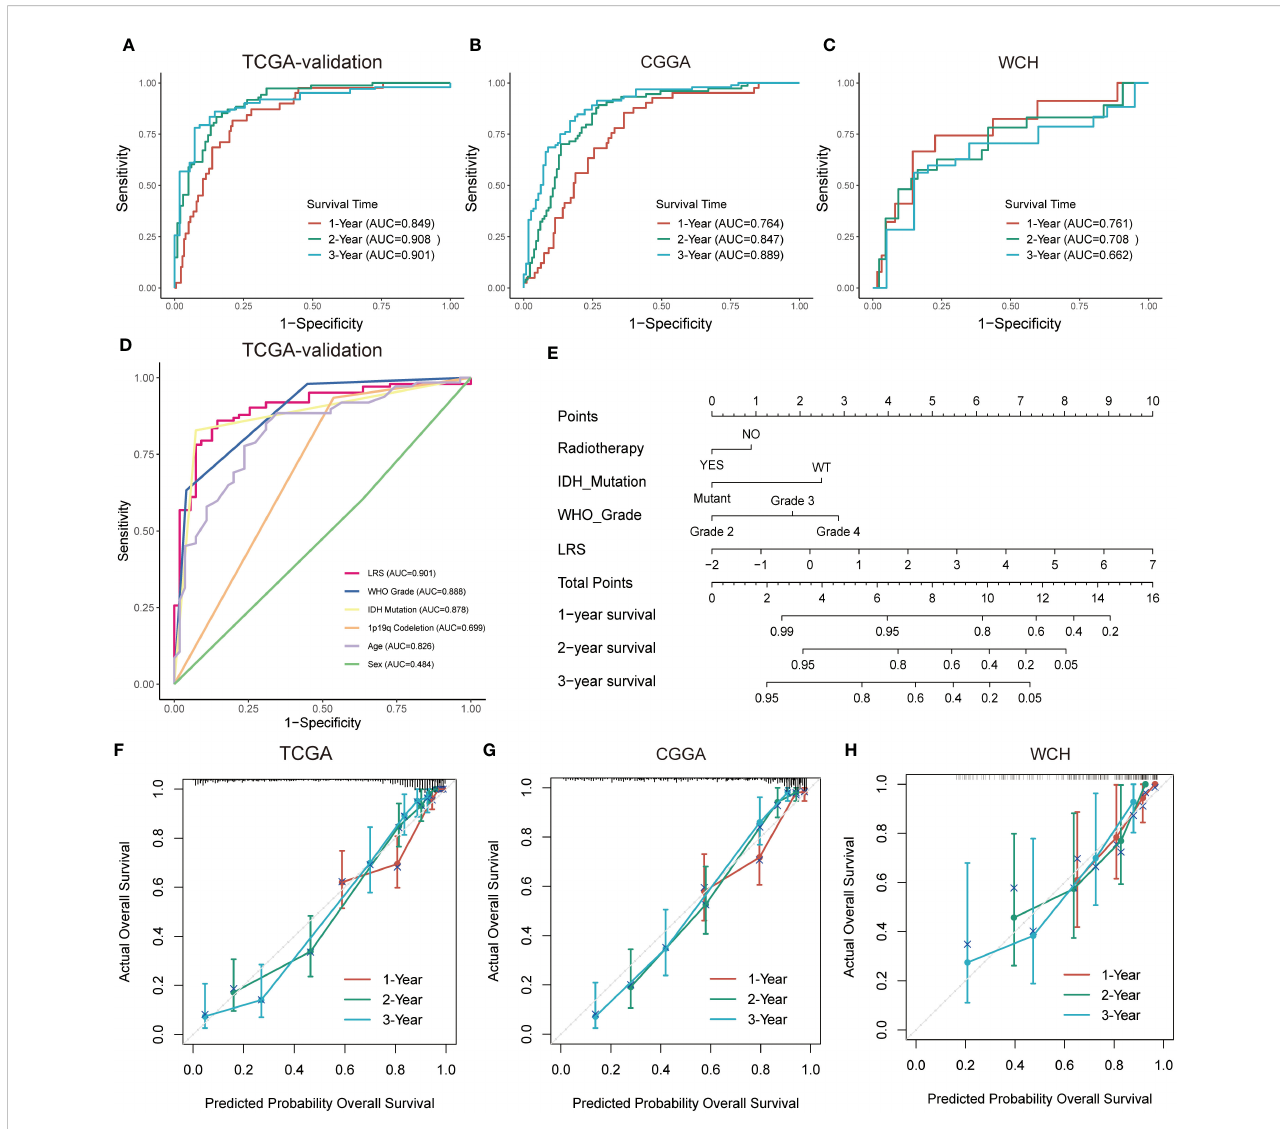
FIGURE 4 Prognostic predictive performance of LRS and nomogram construction. (A – C) , ROC curves for predicting 1-, 2-, 3-year overall survival in TCGA-validation group, CGGA, and WCH cohort; (D) , overall survival prediction based on clinicopathological variables in TCGA-validation cohort. (E) , Nomogram construction based on independent prognostic clinical variables; (F – H) , Calibration curve for assessing the performance of nomogram in entire TCGA, CGGA, and WCH cohort respectively. LRS, lipid metabolism risk score; ROC, receiver operator